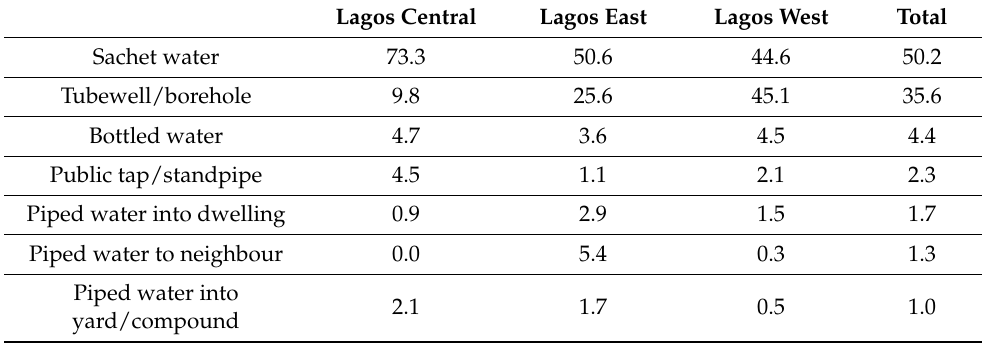
Table 7. Main source of drinking water by Senatorial Ward (%